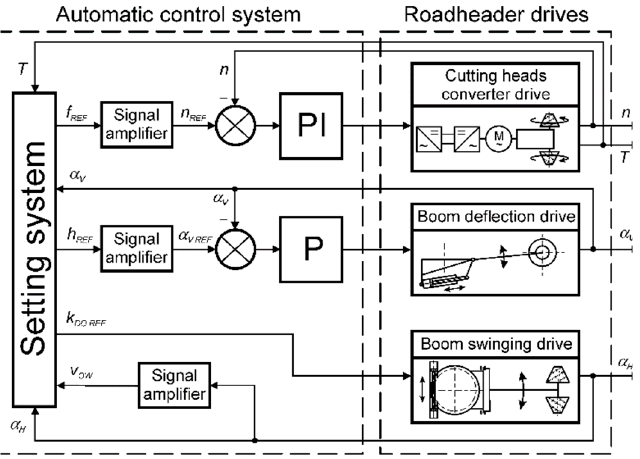
Figure 2. A simplified diagram of the automatic control system developed for controlling the cut- ting heads movement of a boom-type roadheader according to the proposed concept: n —rotational speed of the motor rotor driving the cutting heads, v OW —movement speed of the cutting heads, α H & α V —boom deflection angles in a plane parallel and perpendicular to the floor.